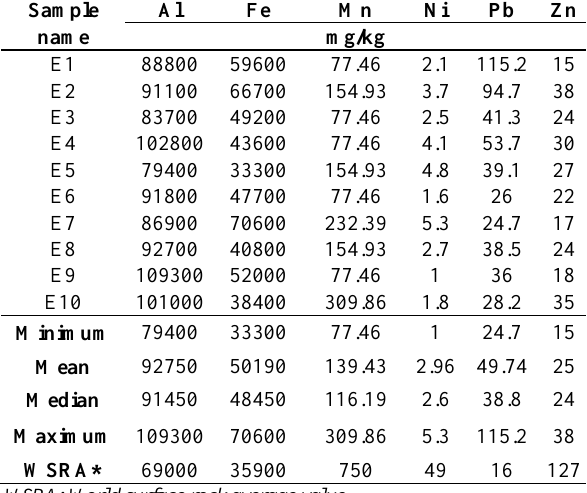
Table 2. Some metal concentrations of mine wastes